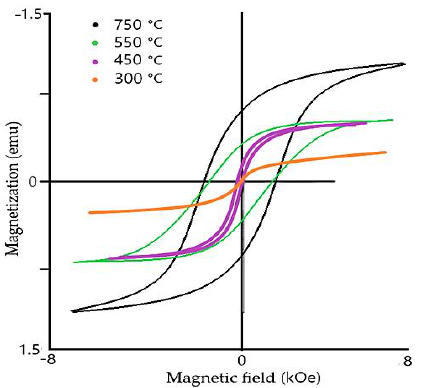
Figure 5. Temperature-dependent magnetic hysteresis loop of BFO material.